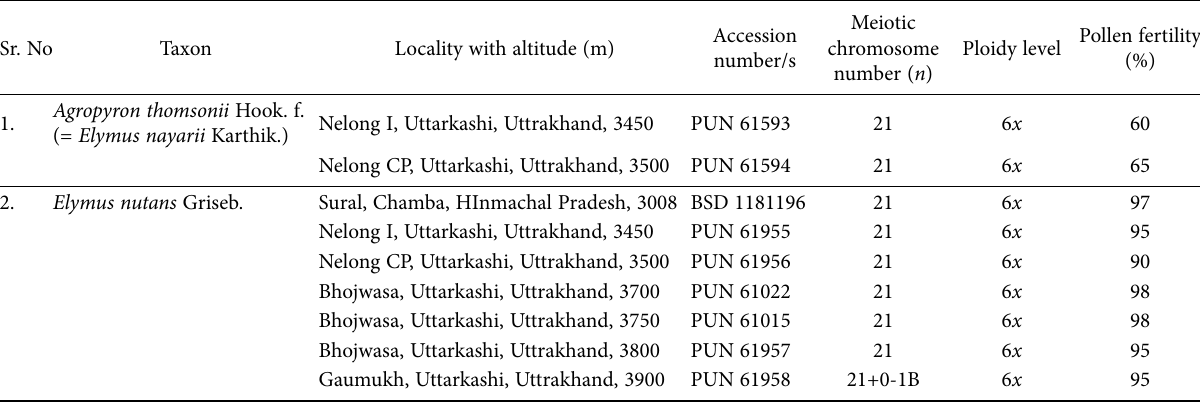
Table 2. Data on the percentage of PMCs involved in chromatin transfer, abnormal sporads and pollen size of Agropyron thomsonii and Elymus nutans.